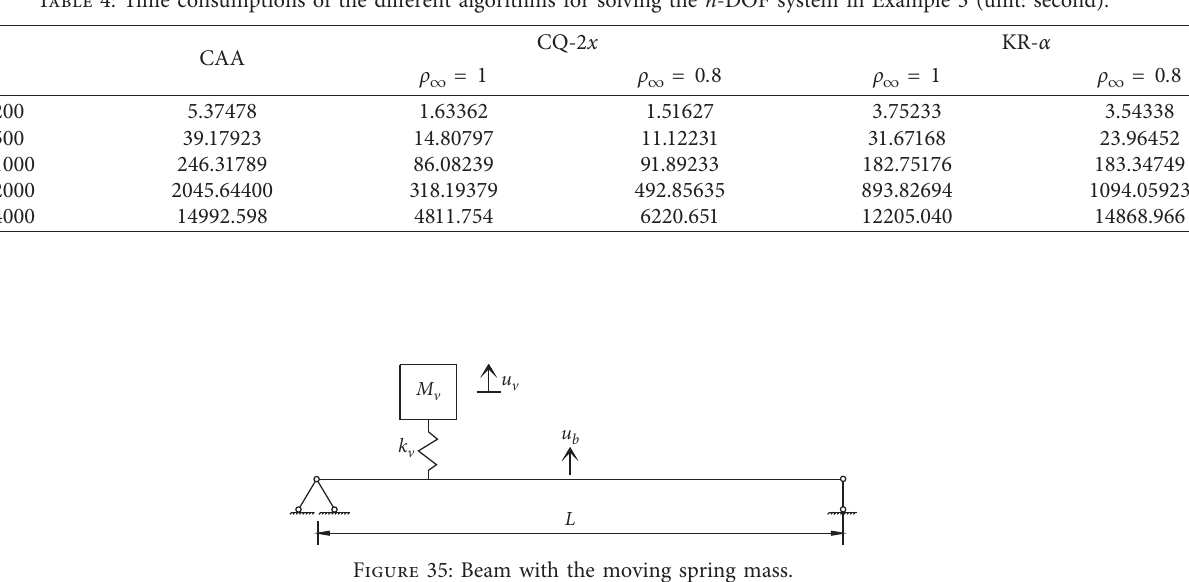
Table 4: Time consumptions of the different algorithms for solving the n -DOF system in Example 3 (unit: second).